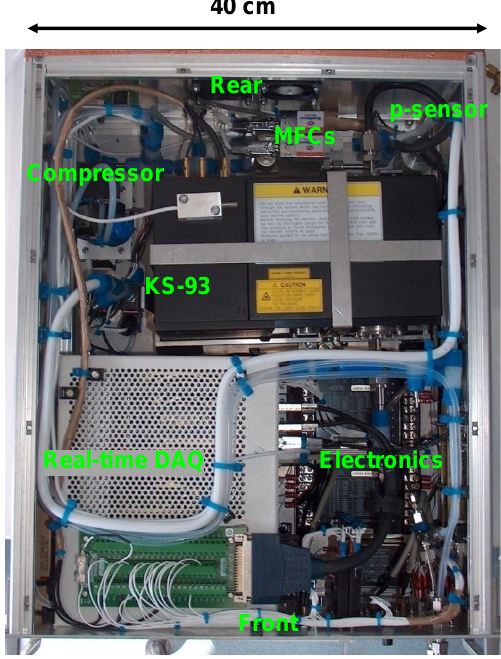
Figure 1. Top view of the CARIBIC optical particle size spectrom- eter